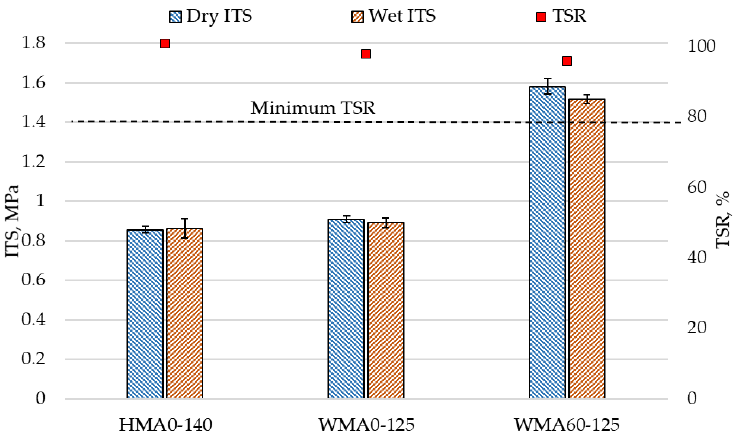
Figure 7. Moisture susceptibility results.